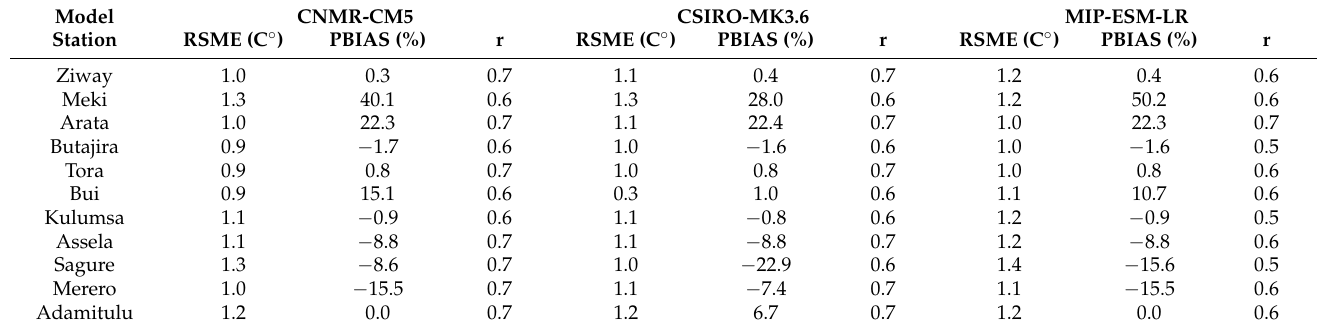
Table A2. Statistical indices values of GCMs–CMIP5 output monthly maximum temperature during 1983–2005 over Ziway Lake